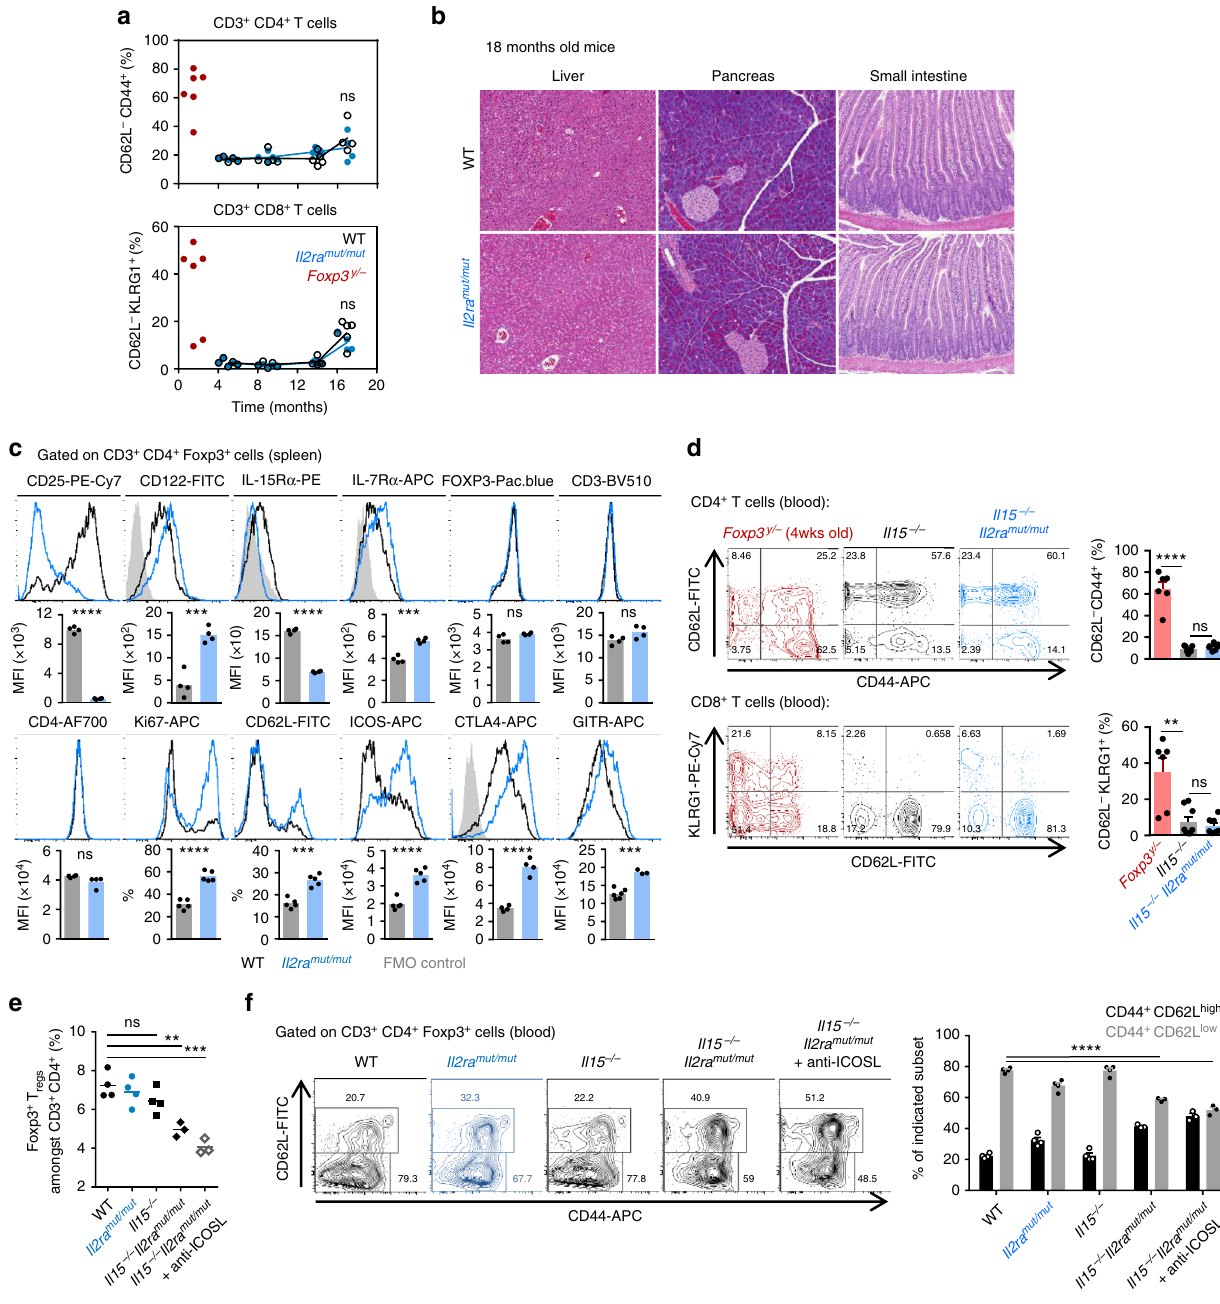
Fig. 6 Il2ra mut/mut mice do not develop any signs of autoimmunity: a T cells collected from blood of Il2ra mut/mut and WT mice were stained for cell-surface CD3, CD8, CD4 and CD62L, CD44, KLRG1 activation markers at indicated times over an 18 months period. Blood from control Foxp3 y/ − was analyzed at ~1.5 months post birth. Each symbol represents an individual mouse. b At month 18, liver, pancreas, and small intestine were harvested, fi xed/cut, and stained with H/E. c Spleen cells from 8 to 10-weeks-old Il2ra mut/mut and WT mice were stained for cell-surface CD3, CD4, intracellular Foxp3 and indicated markers. Overlay of representative FACS histograms after gating on CD3 + CD4 + Foxp3 + T cells are shown and bar graphs average relative expression levels (MFI, n = 4 – 5). d Blood from Il2ra mut/mut Il15 − / − , Il15 − / − (6 months old) or Foxp3 y/ − mice was stained as in a and representative FACS dot plots with bar graphs summarizing average across mice ( n = 6 – 7) are shown. e Proportion of peripheral blood Foxp3 + T reg cells among CD3 + CD4 + T cells in indicated mice treated (or not) with anti-ICOSL for 2 weeks. f Blood leukocytes from indicated mice groups were stained for expression of CD3, CD4, intracellular Foxp3, CD62L, CD44. Representative dot plots and summary bar graphs of average CD44/CD62L expression levels across all groups of mice are shown ( n = 3 – 4). p -values are indicated when relevant with * p < 0.05; ** p < 0.01; *** p < 0.001; NS not signi fi cant, using two-tailed unpaired Student ’ s t-